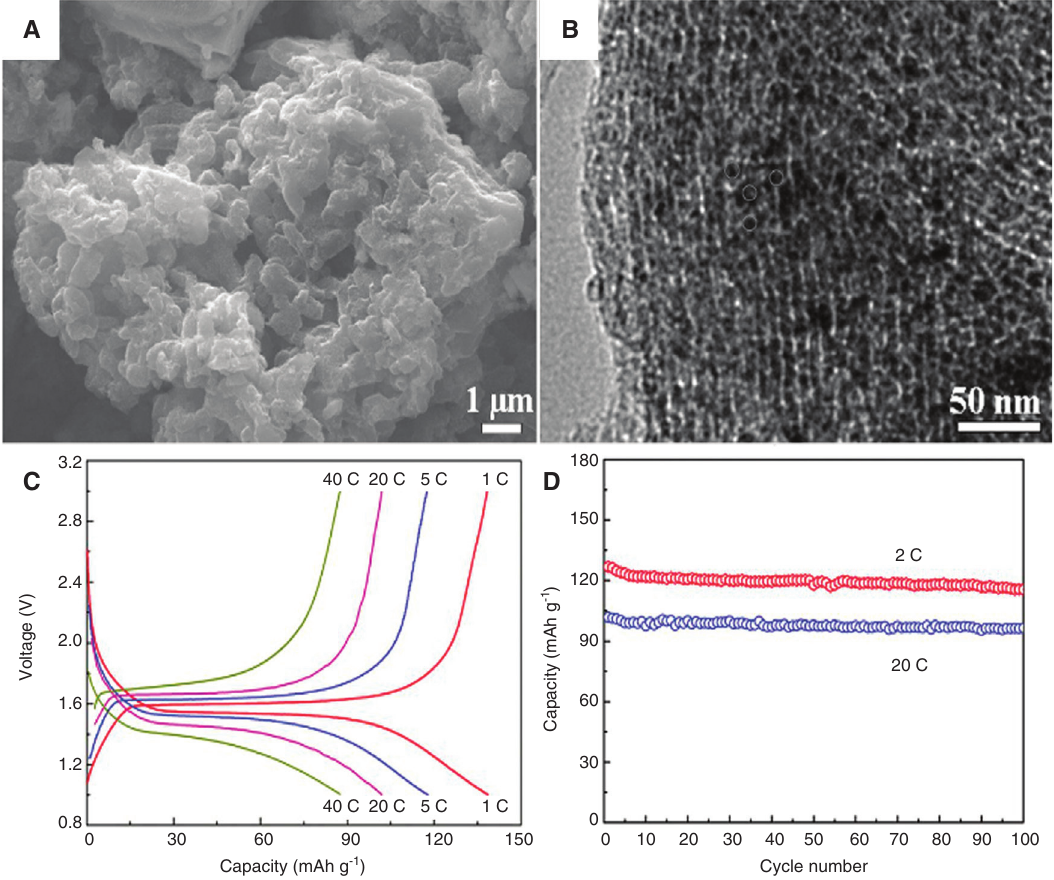
Ti O /carbon nanocomposite, showing that Li 4 5 12